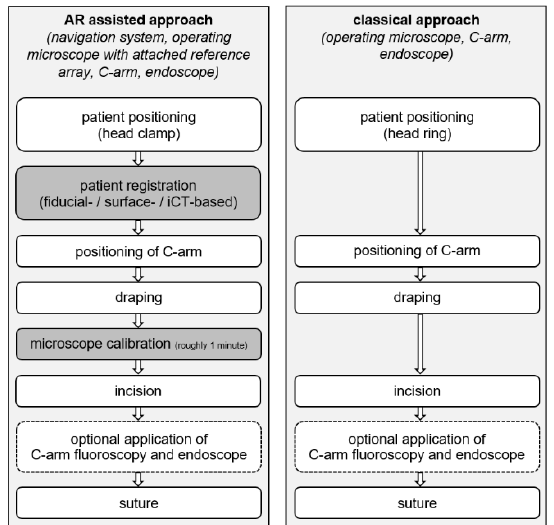
Figure 1. Overall workflow of the AR assisted ( left ) and classical ( right ) approach outlining at which point the additional techniques are integrated in the clinical workflow. Integration encompasses patient registration for navigation purposes as well as calibration of the operating microscope allowing for AR support throughout surgery and is performed prior to incision, not affecting surgery